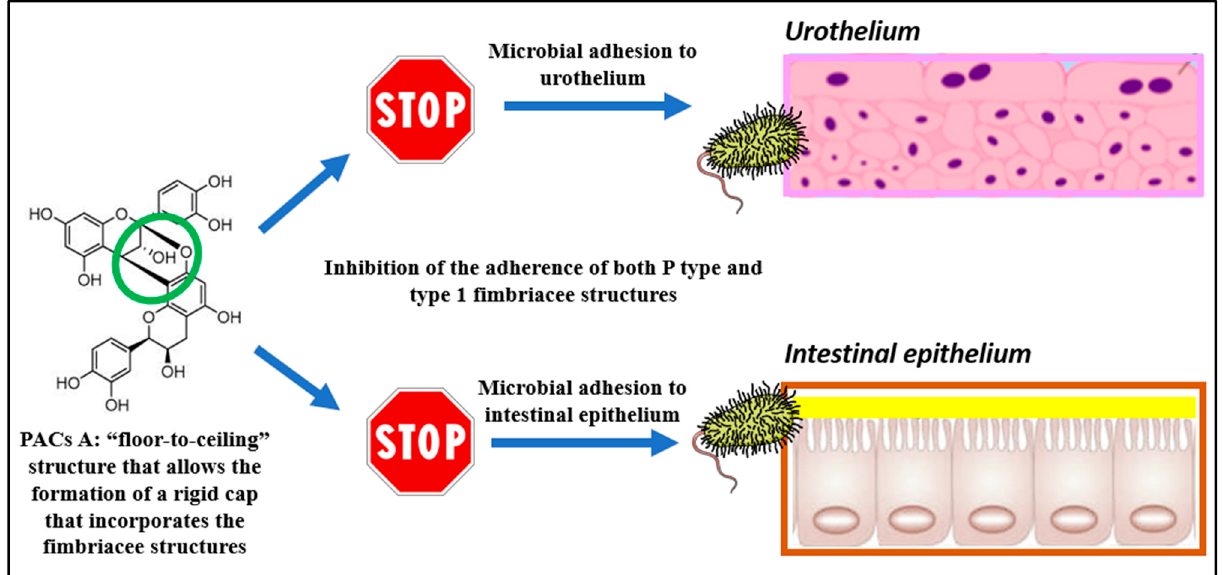
Figure 3. A-type proanthocyanidins (PACs A) and anti-uropathogenic mechanism of action. The meta-analysis by Fu et al., including 7 RCTs conducted on healthy women ( n = 1498) at risk of UTIs showed that cranberry reduced the risk of UTIs by 26% (pooled risk ratio: 0.74; 95% CI: 0.55, 0.98), suggesting the possible effect of this nutraceutical in pre- venting uncomplicated UTI recurrence in healthy people [74]. Similar results were ob- tained by another meta-analysis of 28 RCTs (RR: 0.67, 95% CI 0.55–0.79, p < 0.0001) [81]. However, data on complicated UTIs prevention with cranberry remains unclear and in part contrasting as reported by four previous meta-analyses [71,82–84], among which only three reported a trend of relative risk reduction after cranberry supplementation [71,82,83]. Cranberry proanthocyanidins and their metabolites also act by reducing the intestine reservoir of potential uropathogenic bacteria. In particular, cranberry flavonoids might decrease the intestinal colonization of opportunistic extra-intestinal E. coli and thus, the risk of UTIs incidence [85]. At the same time, the gut microbiota has been shown to interact positively with cranberry flavonoids in a “two-way interaction”, improving the conver- sion of active metabolites which might enhance the anti-UTI effects and promote the in- testinal eubiosis [86]. For example, phenyl- γ -valerolactones are one of the most important metabolites of cranberry found in the urine, with exhibited antiadhesive activity in vitro [87]. Therefore, the heterogeneity of results of cranberry supplementation against UTIs might be also attributed to the inter-variability of gut microbiota composition, which might influence the conversion of cranberry flavonoids into bioactive molecules.